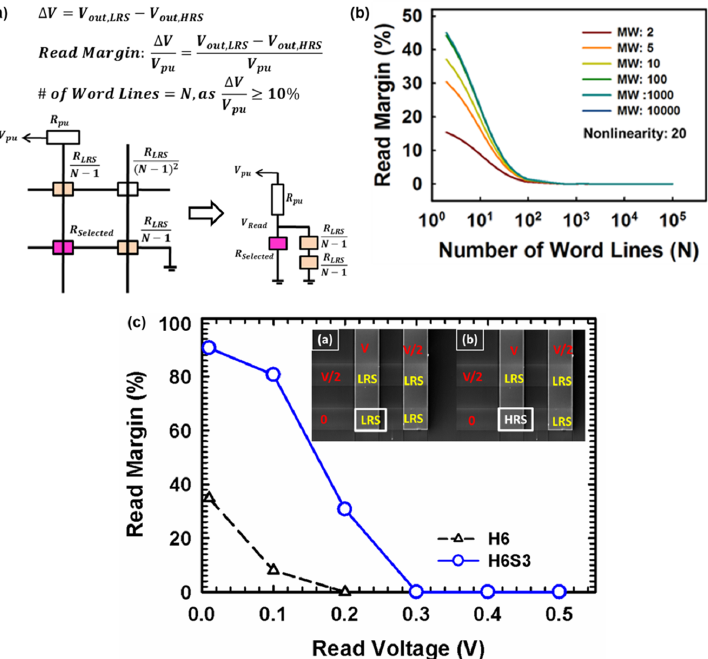
Figure 4. ( a ) Normalized current of cell numbers after N4 electroformation, ( b ) Simulated results with fixed NL (~20) with various memory window (~2–10 4 ). The read margin remains as the MW >10 2 , ( c ) read margin with the V/2 read scheme applied on 2 × 2 array configuration with the HfO x (6 nm)/SiO x (3 nm) memory with self-rectifying effect, and HfO x (6 nm) single-layer device. Noted that the SPC is lowered when the selected cell is at a high resistance state (HRS) due to larger resistances in the crossbar array. The number of wordline (N) (i.e. array size) is extracted on the premise of a 10% read margin. The read margin is suggested as domi- nated by the SPC immunity of selectorless RRAM, and independent on memory window (MW) once MW > 10 2 (Figure 4b). The memory window is defined as the resistance ratio of high resistive state and low resistive state i.e. on-off ratio of the memory. The read mar- gin increases with the number of wordline decreasing, which is owing to a lower sneak path current through the unselected neighboring cells. In other words, the read margin deteriorates as memory size becomes larger and larger, where the sum of SPC is larger in a larger memory array. Besides, the device size dependency is studied with measured values of MW and SPC immunity with various device structures. The SPC immunity is independent of the device sizes for various structures, which suggests the localized fila- ment switching and the potential for high scalability on this bilayer selectorless RRAMs (data not showed). The V/2 read scheme is applied on a 2 × 2 array, which is configured by the HfO x (6 nm)/SiO x (3 nm) memory cells with self-rectifying effect as HfO x (6 nm) single-layer cells. The read margin degrades with increasing read voltages, which depicts that the sneak path currents issue in the array is worse when the read voltages increased (Figure 4c). The pull-up resistor is used for the voltage drop measurement to calculate the read margin by definition [38]. The read margin is defined as the voltage drop (ΔV) divided by the pull-up voltage applied externally, where the sneak path current caused the voltage drop when the selected cell is at a low resistance state (LRS) i.e less resistive and higher SPC. Noted the resistance of the pull-up resistor is chosen as the LRS on the cell (~5 MΩ). The read margin decreases with increasing read voltage is due to the increment of voltage drop when the cell in HRS (i.e. V HRS ). In other words, the sneak path current generated